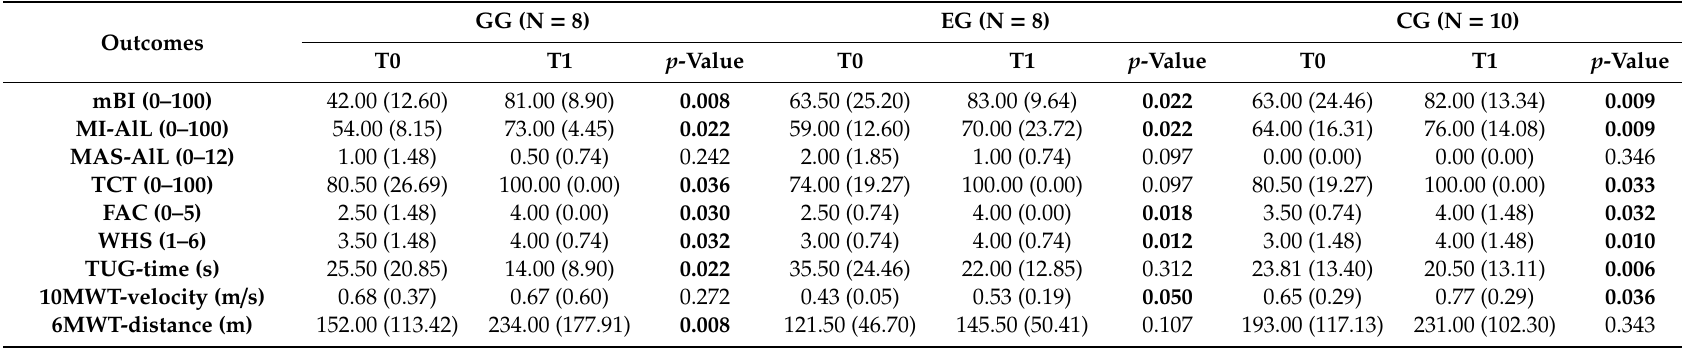
Table 2. Clinical outcomes at the beginning (T0) and at the end (T1) of the gait treatment for all groups and the corresponding p -values obtained with the statistical analysis.